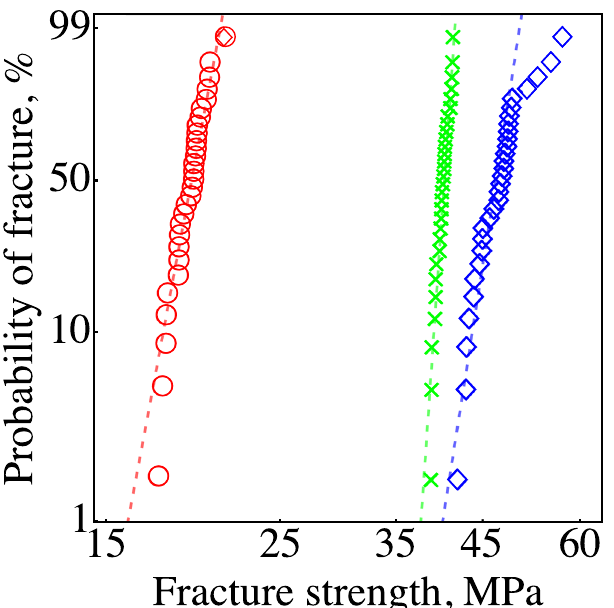
Figure 8. Weibull plot of fracture stress for the extruded filament ( ◯ ), M1 filament ( × ), and M2 filament ( ◇